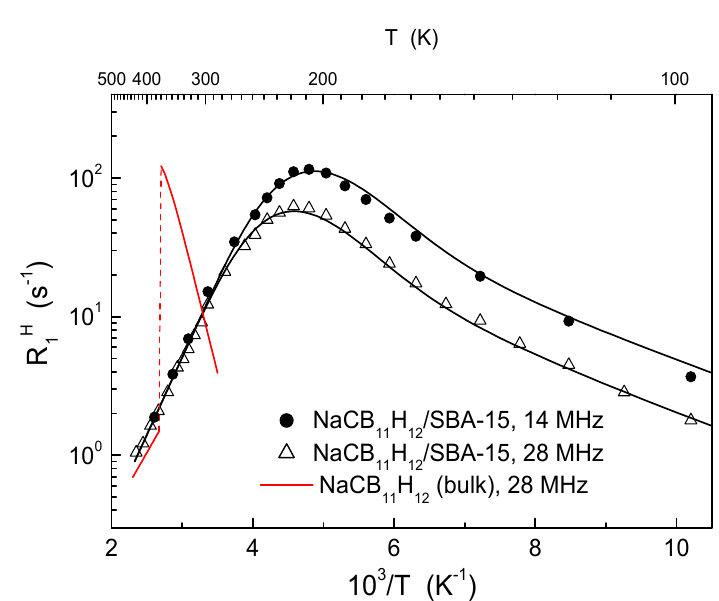
Figure 6. Proton spin–lattice relaxation rates measured at the resonance frequencies of 14 and 28 MHz in the nanoconfined NaCB 11 H 12 / SBA-15 system (average pore diameter of 8 nm) [99]. The black solid lines show the simultaneous fit of the two-peak model to the data. For comparison, the red line shows the behavior of the proton spin–lattice relaxation rate in bulk NaCB 11 H 12 [71].